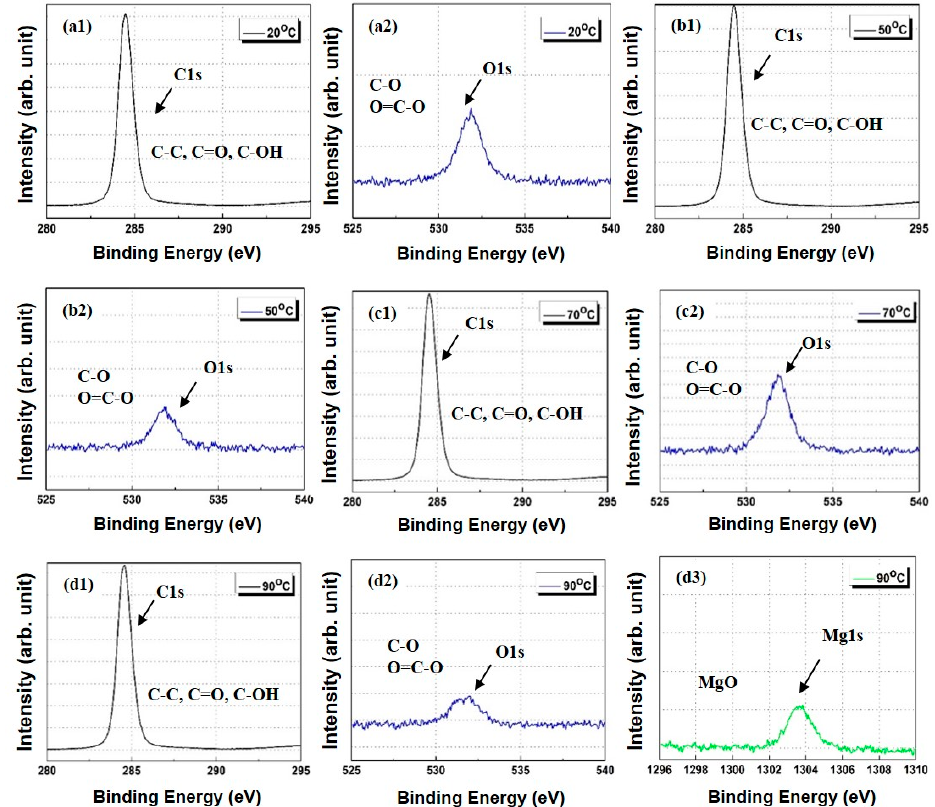
Figure 8. XPS spectra of polypropylene/lubricant (Mg) composites aged at different temperature conditions at 100% humidity: ( a ) C1s and O1s spectra at aging temperature of 20 °C; ( b ) C1s and O1s spectra at aging temperature of 50 °C; ( c ) C1s and O1s spectra at aging temperature of 70 °C; ( d ) C1s, O1s, and Mg1s spectra at an aging temperature of 90 °C.